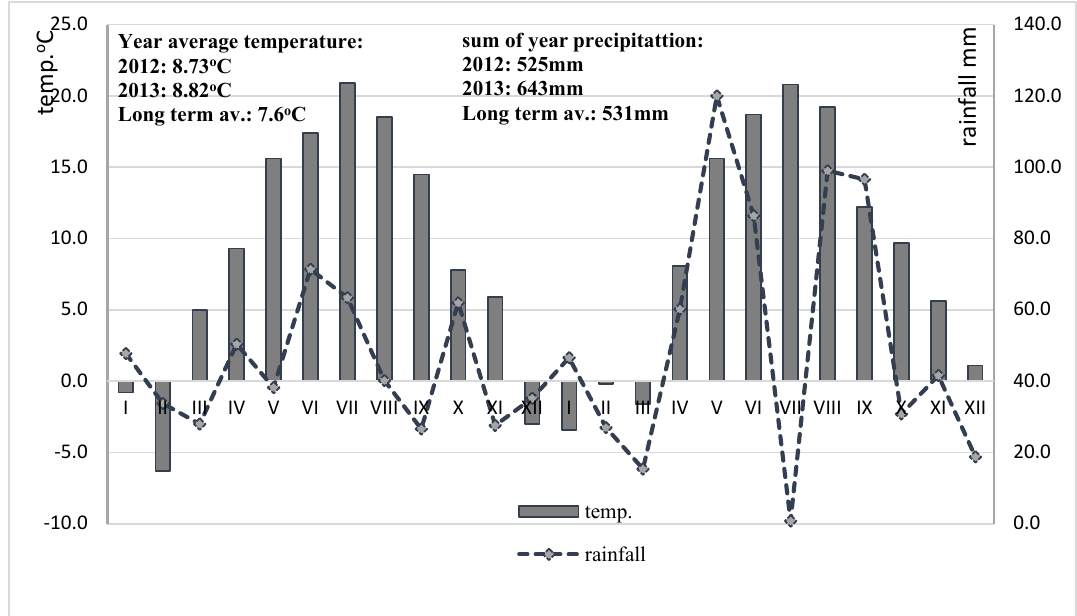
Figure 1. Data on mean monthly temperatures and rainfall at the experimental site in the 2012 and 2013 growing periods. Long term averages (av.) were calculated for the period 1982–2012.